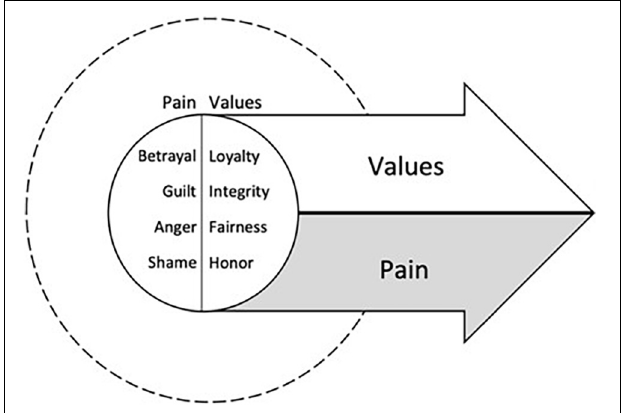
FIGURE 1 | The treatment targets of Acceptance and Commitment Therapy for Moral Injury (ACT-MI), pursuing values in the presence of moral pain.